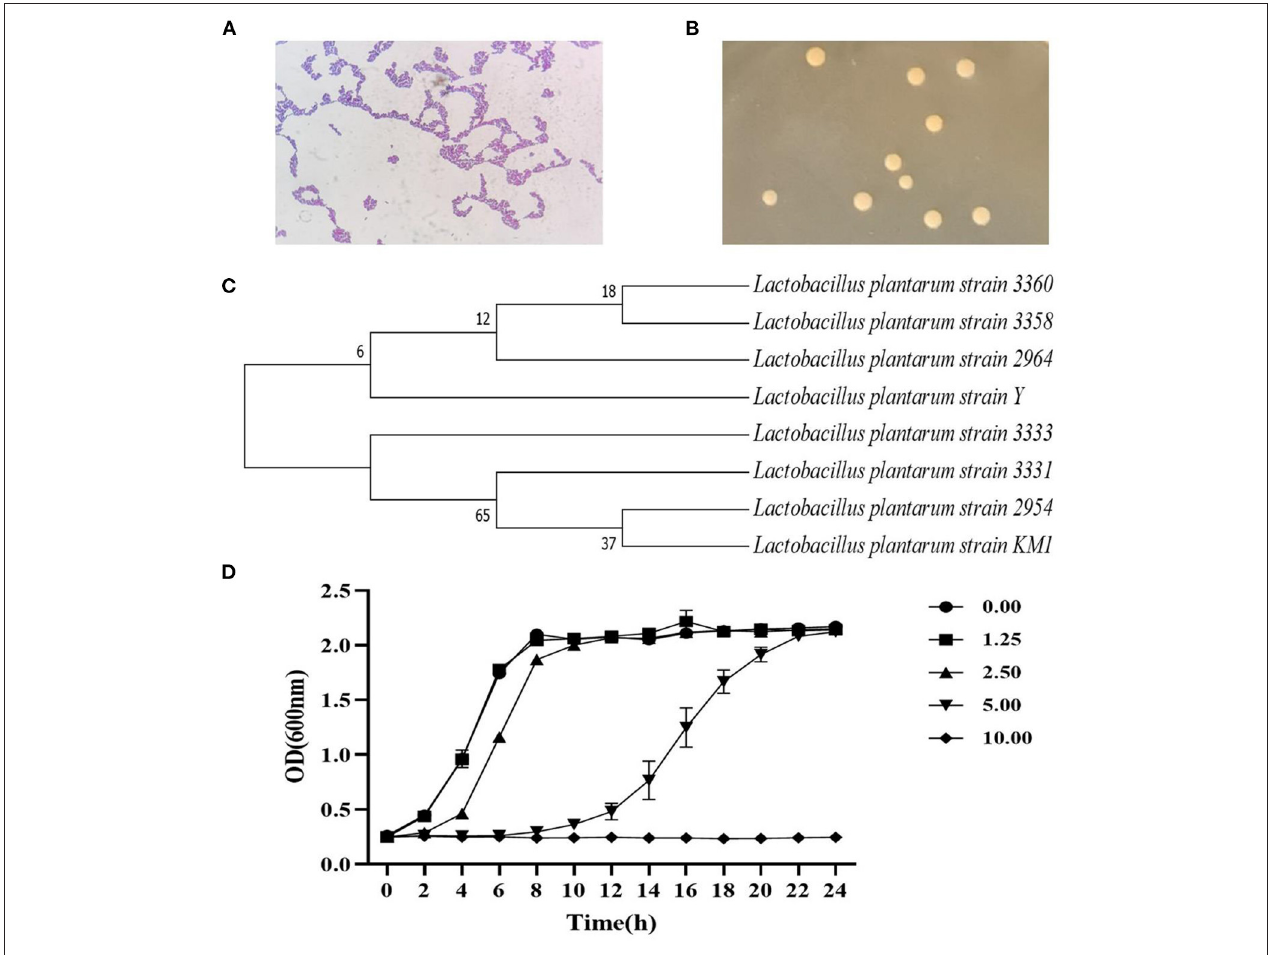
FIGURE 1 | The identification of strain by the 16S rDNA sequence and its growth curve. The strain characteristics (100 × ) (A) , colony morphology (B) , and the phylogenetic tree (C) of L. plantarum KM1. Growth of L. plantarum KM1 under the stress of different concentrations of H 2 O 2 (D) .